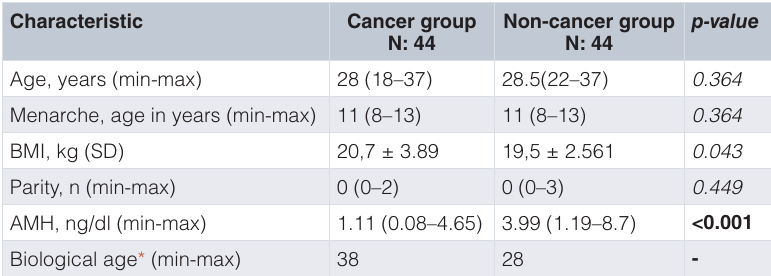
Table 1. Baseline characteristics.